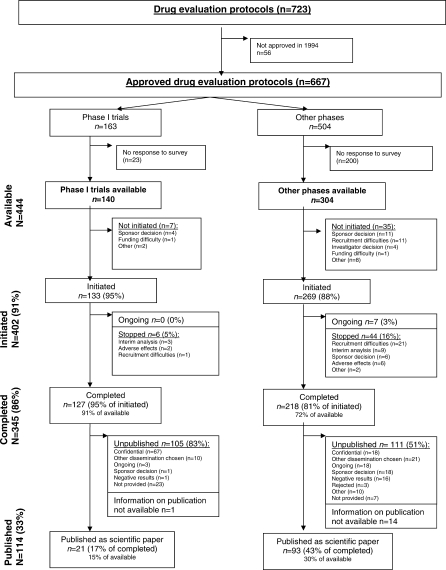
Flow Chart of Studies